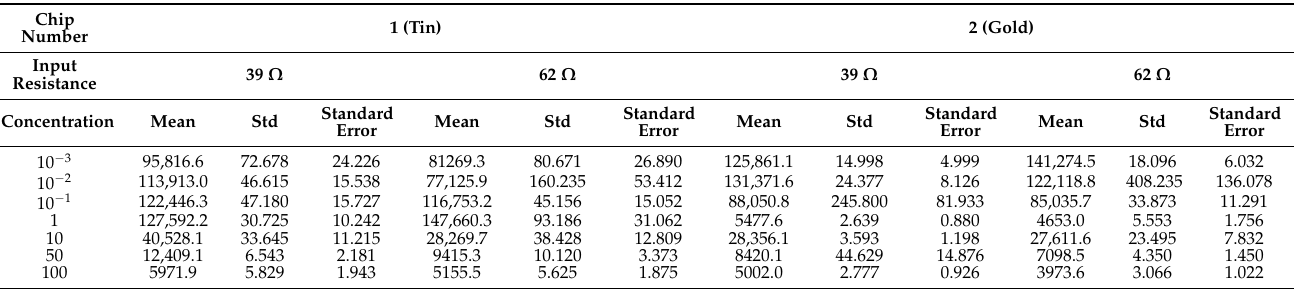
Table 1. Analysis according to electrode